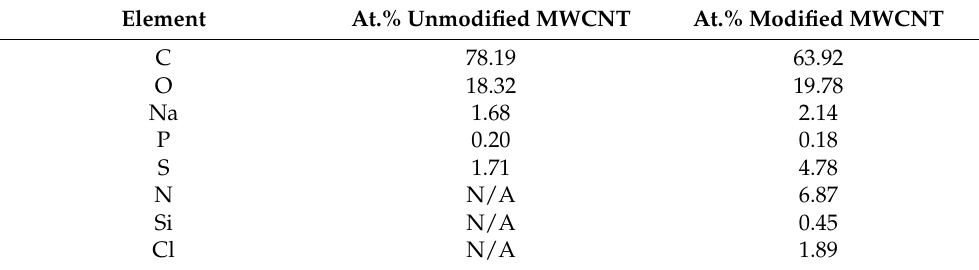
Table 1. Elemental composition EDX analysis of MWCNTs in A) unmodified form dispersed in dH 2 O and B) enzymatic solution after complete conjugation ( n = 3).